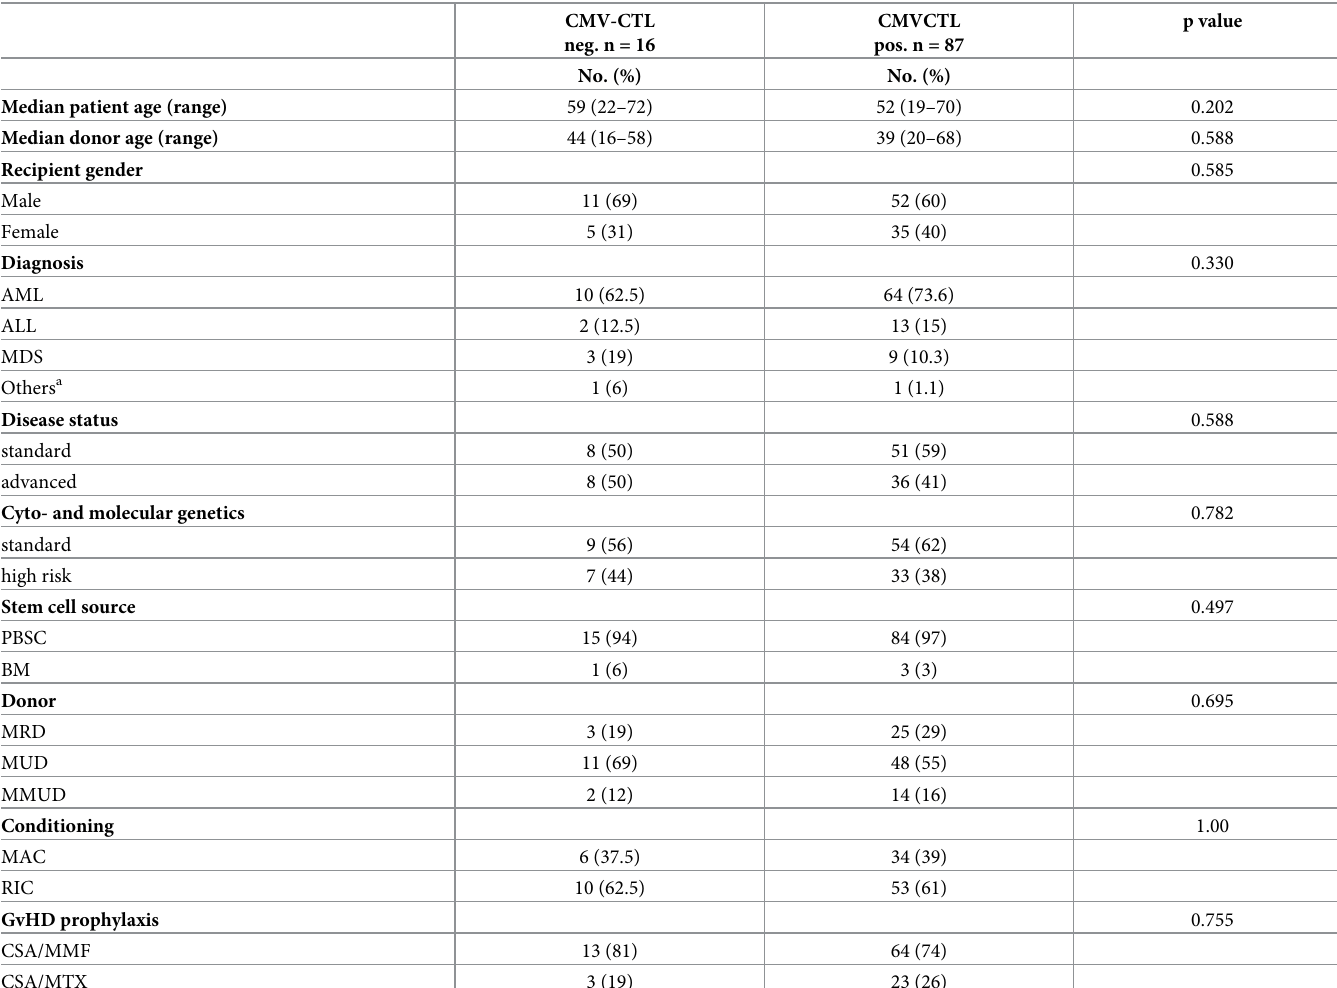
Table 1. Patient